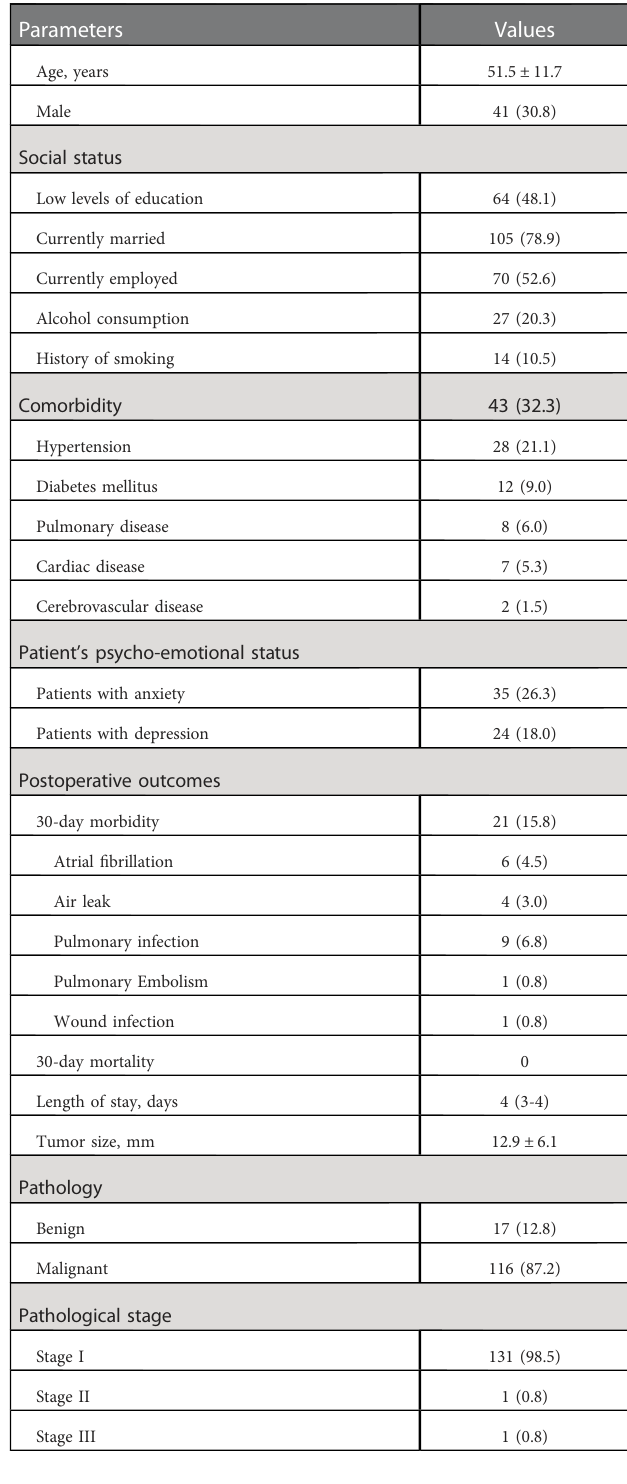
TABLE 1 Basic patient characteristics and perioperative